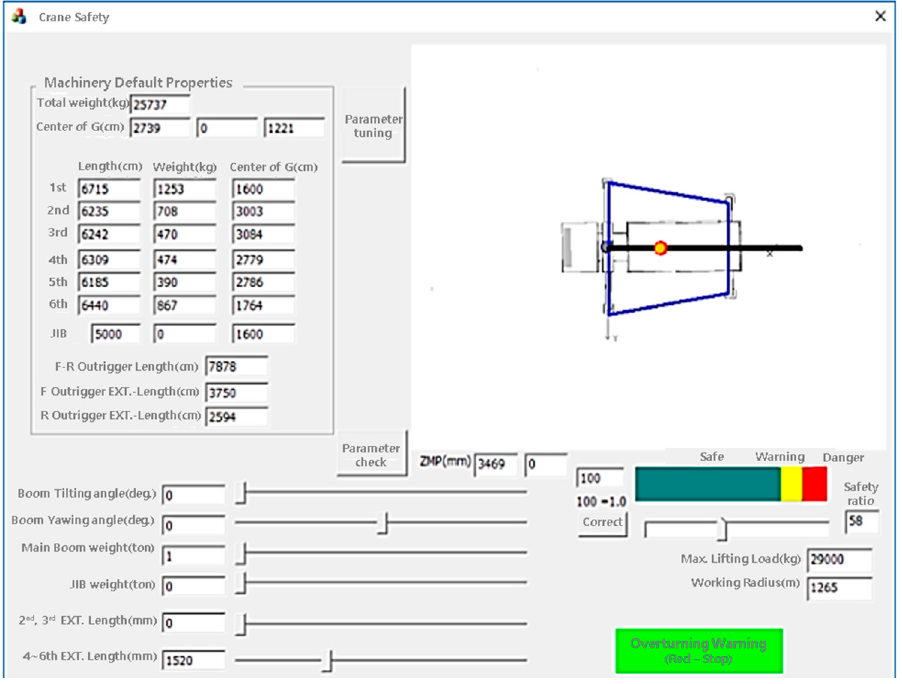
Figure 6. The mobile crane control program UI.